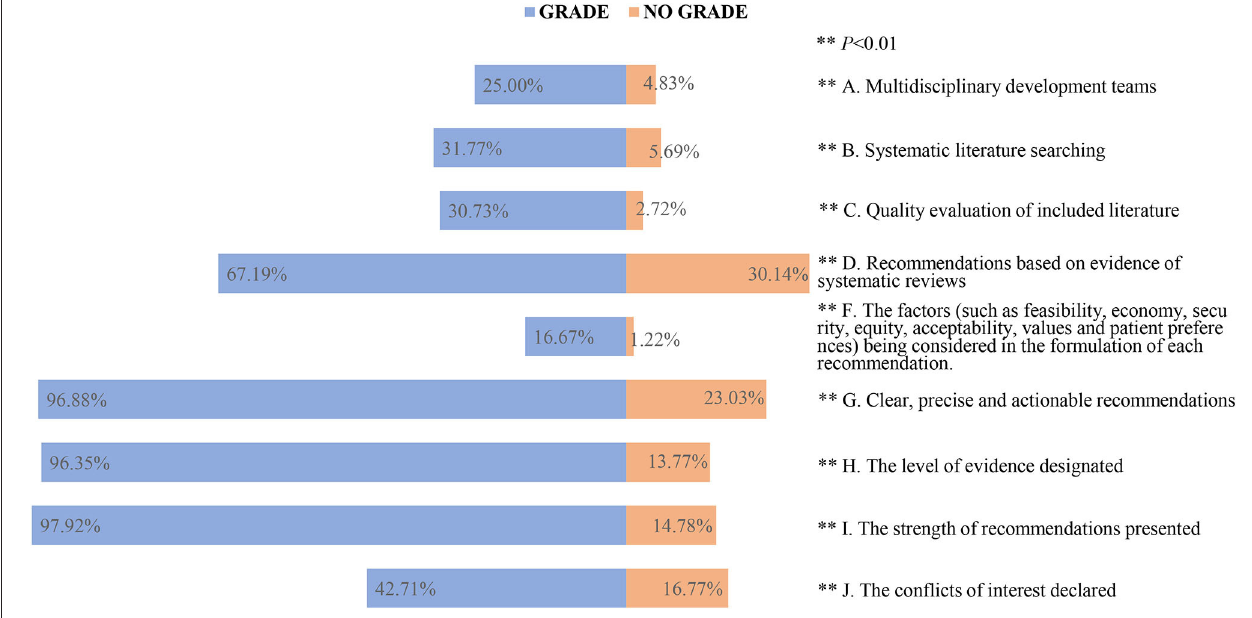
FIGURE 5 | The methodological characteristics in the guidelines using and not using